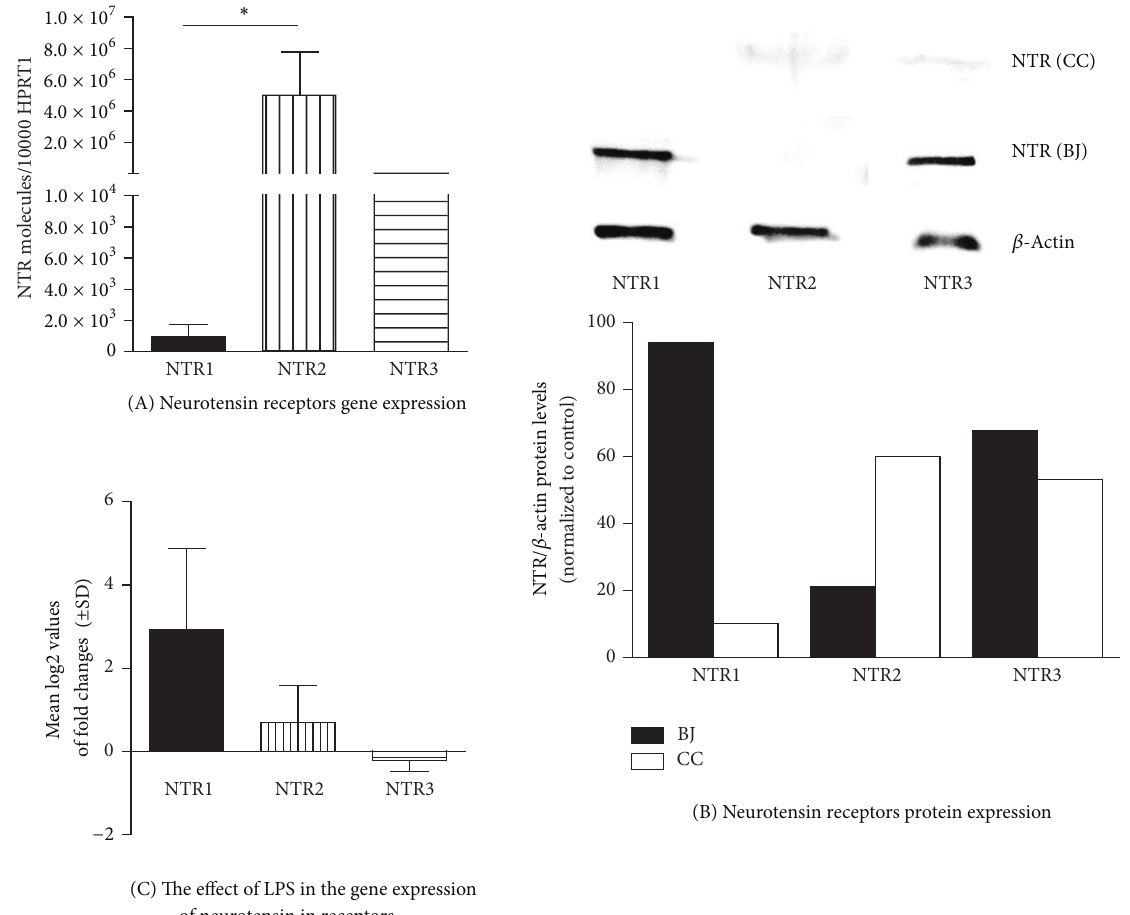
Figure 1: Neurotensin receptor mRNA and protein expression. Cells were maintained in medium (A, B) or treated with 1 𝜇 g/mL of LPS for 6 h (C), at 37 ∘ C, with 5% CO 2 . Total RNA was isolated and retrotranscribed as indicated in Section 2. The mRNA levels were assessed by quantitative real-time RT-PCR. Gene expression is indicated as genes studied/10,000 molecules of the reference gene HPRT1 (A) or mean log2 values of fold changes relative to the control (C). Each value represents the mean ± SD from three independent experiments ( ∗ 𝑃 < 0.05 ; Kruskall-Wallis test followed by Dunn’s multiple comparison posttest). Cells extracts from untreated BJ cells (BJ) and from the murine cortical cortex (CC) were subjected to Western blot analysis (B) using NTR1, NTR2, and NTR3 antibodies, with normalization to 𝛽 -actin. The blot shown is representative of 3 independent experiments yielding similar